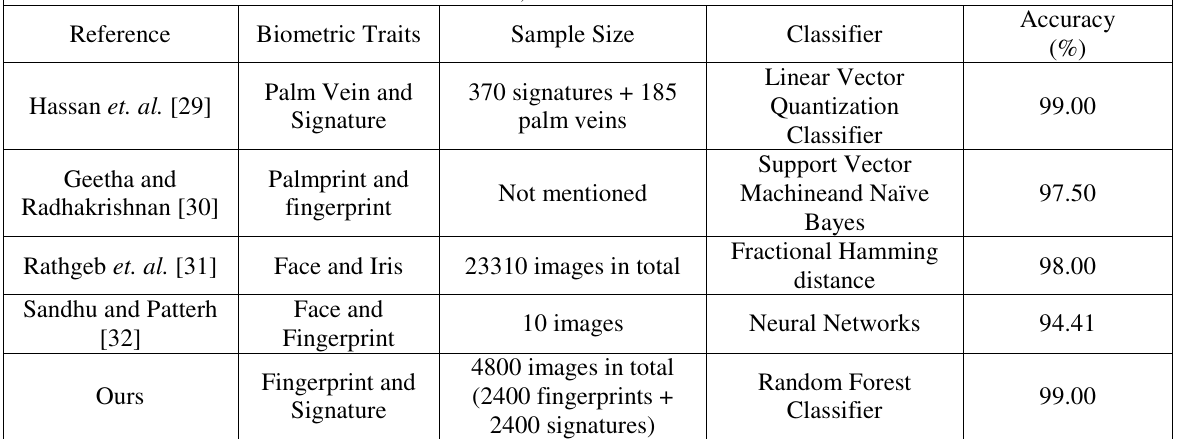
TABLE 3: BIOMETRIC FUSION SAMPLE SIZE, MODALITIES AND RECOGNITION ACCURACY